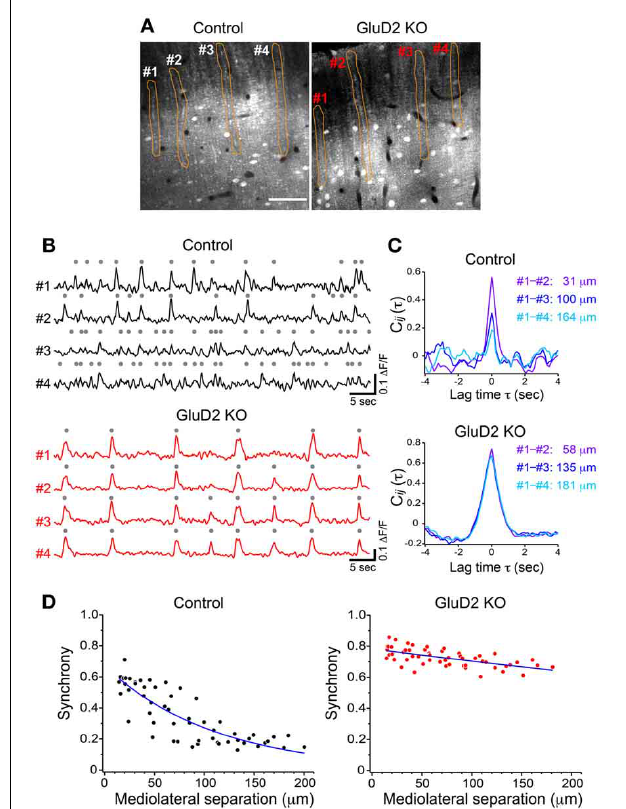
FIGURE 1 | Synchrony of spontaneous calcium transients in control and GluD2 KO mice. (A) Fluorescence images showing the molecular layer of the cerebellar cortex labeled with OGB-1 AM in control and GluD2 KO mice. PC dendrites are seen as gray bands that extend along the rostrocaudal axis and aligned perpendicular to the mediolateral axis. Spontaneous calcium transients were obtained by monitoring fluorescence changes of the specified regions of interest (ROIs; orange). Scale bar, 50 μ m. (B) Representative traces of calcium transient from 4 dendrites (#1–#4) that correspond to the ROIs in (A) . Gray dots indicate detected calcium transients from the baseline noise. (C) Cross-correlation coefficients for the traces in (B) were calculated between #1 and the other dendrites, and the distances along the axis (mediolateral separation) between the dendrites were measured. Synchrony (i.e., the cross-correlation at zero lag time, see Materials and Methods) in control mice was the highest at the nearest neighboring pair, and gradually decreased as the mediolateral separation increased. In marked contrast, synchrony in GluD2 KO mice was almost constant regardless of the mediolateral separation. (D) Summary graphs for the synchrony between all dendrite pairs plotted against the mediolateral separations from the control and GluD2 KO mice shown in (A) (55 dendrite pairs). Blue curves indicate the exponential fit to the